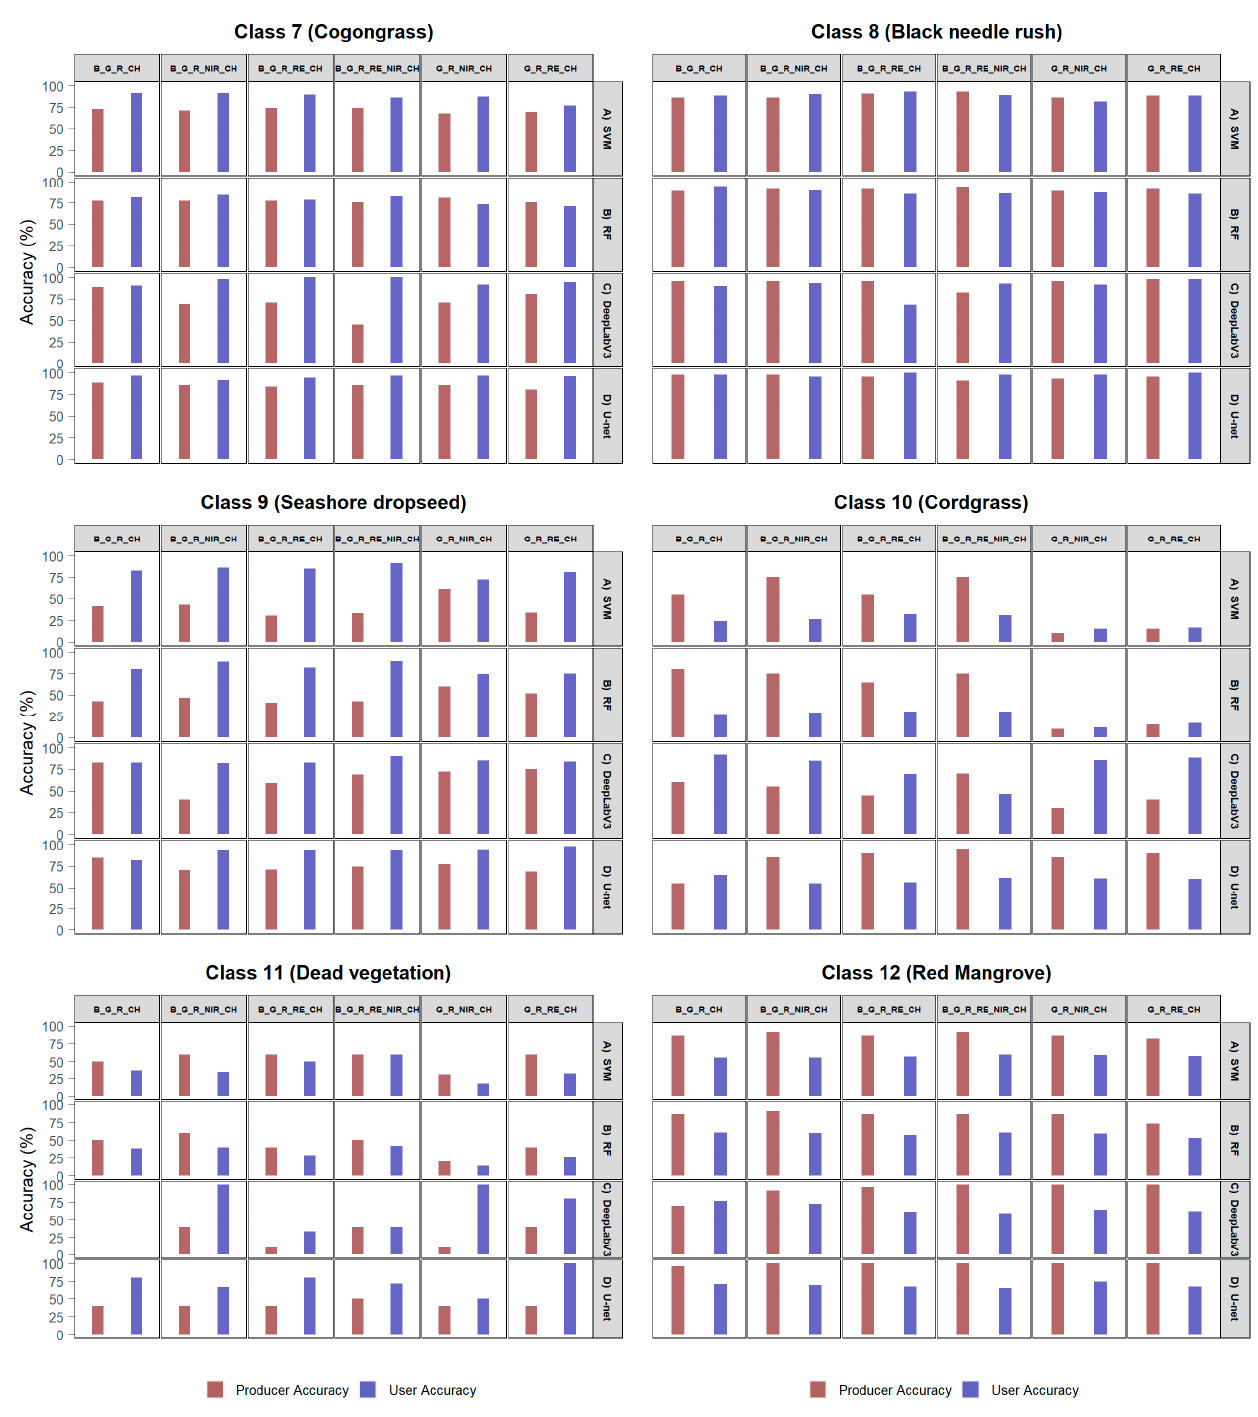
Figure A5. Experiment: EXP2-SB_AB_CHM, producer and user accuracy organized by class and classification method, classes 7 to 12.